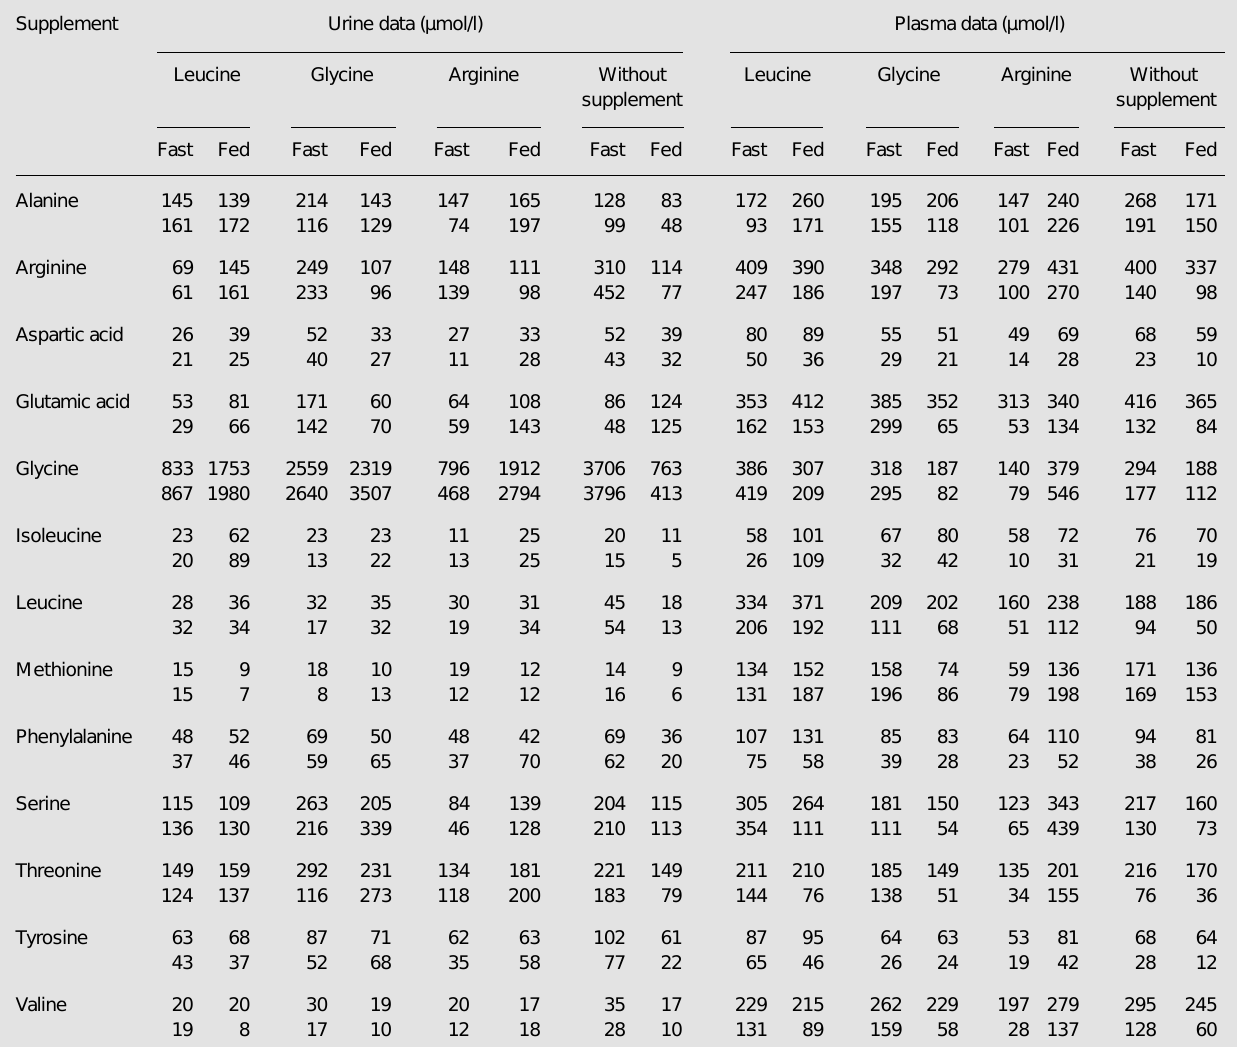
Table 3. Plasma and urinary amino acids before (fast) and after (fed) the kinetic study in obese subjects receiving a low energy rice and bean diet. Supplement Urine data (µmol/l) Plasma data (µmol/l) Leucine Glycine Arginine Without